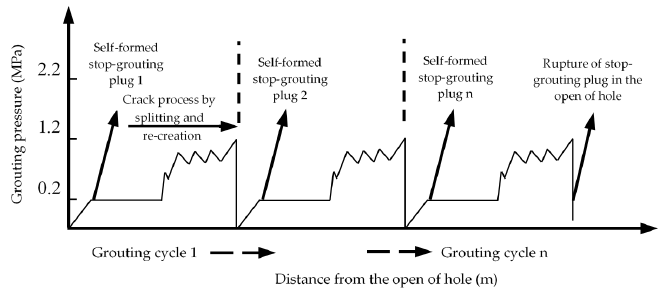
Figure 8. Implementation process and method of controllable grouting for inhomogeneous loose rock mass.